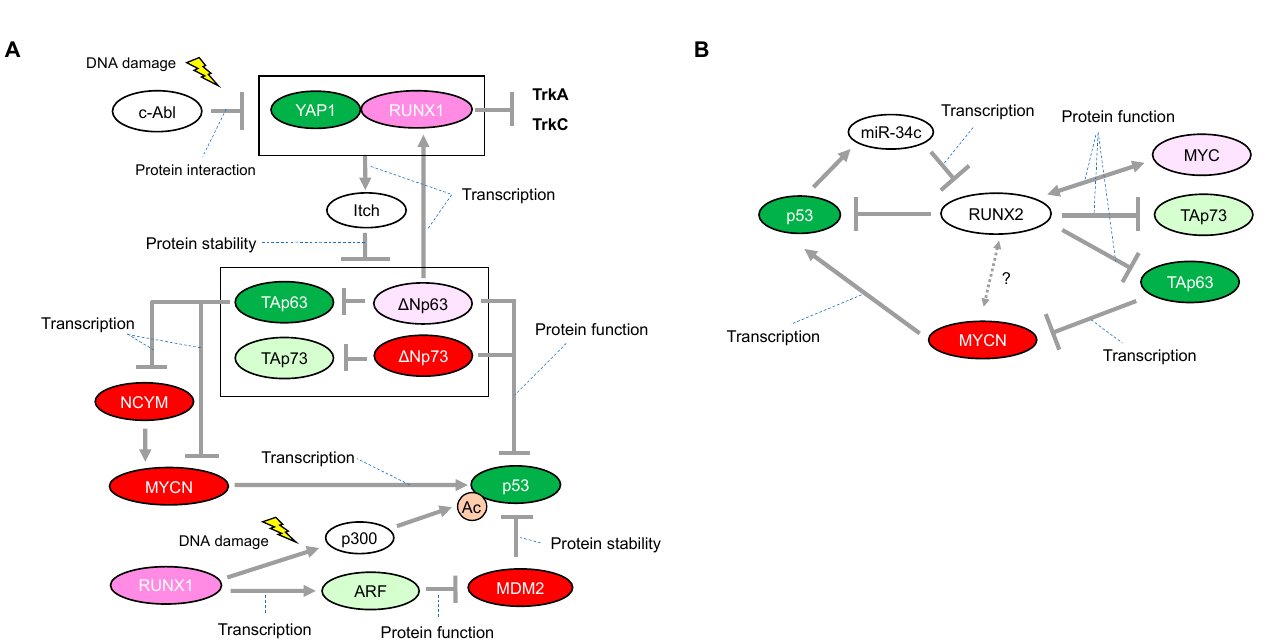
Figure 3. Proposed network of expressional and/or functional regulation between the RUNX1 or RUNX2 and p53 families. ( A ) In response to DNA damage, RUNX1 interacts with Yes-associated protein (Yap1) and collaborates to induce protein degradation of all the p63 and p73 isoforms through the transcriptional activation of Itch, one of the known E3 ligases for p63 and p73. ( B ) Inhibitory roles of RUNX2 on the p53 family. Interaction between RUNX2 and MYCN is unknown. The red-colored or green-colored molecules indicate oncogenes or tumor-suppressors in neuroblastomas, respectively. The pink-colored RUNX1 could positively affect neuroblastoma proliferation The light-pink-colored or light-green-colored molecules could positively or negatively affect neuroblastoma proliferation, respectively, and the non-colored molecules are undetermined.